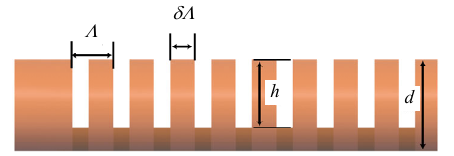
Fig. 1 Schematic diagram of ZnO-nanowire-based nanograting.